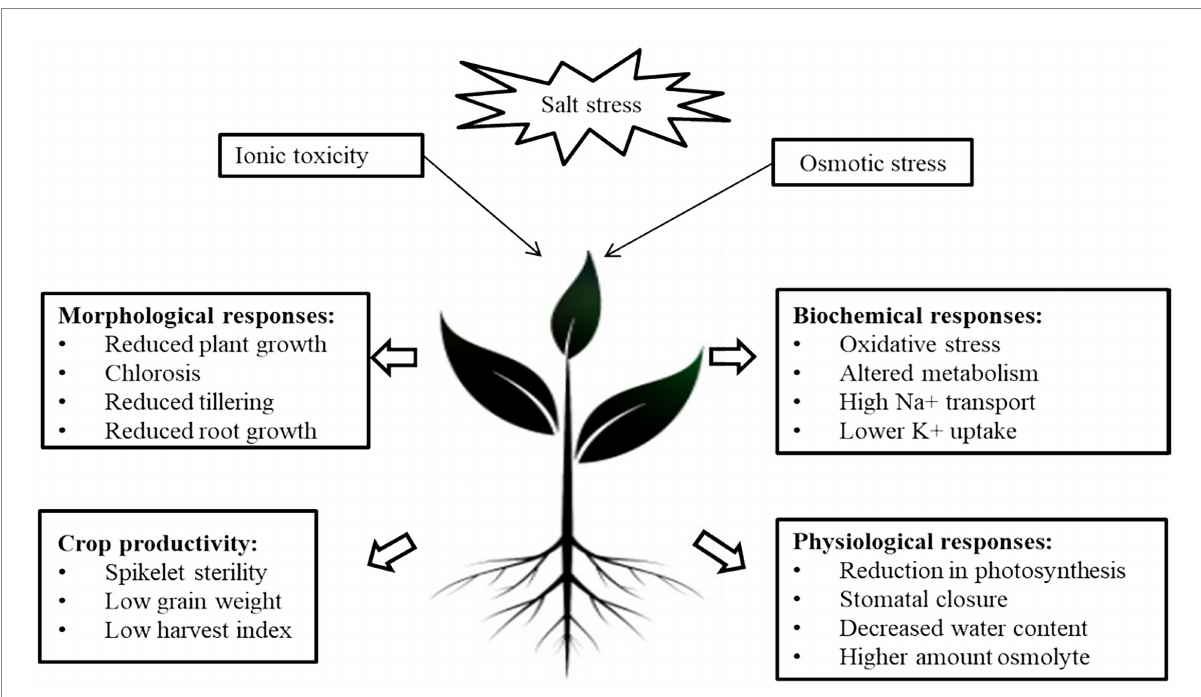
FIGURE 1 Impact of Salinity stress on various physiological and morphological traits of